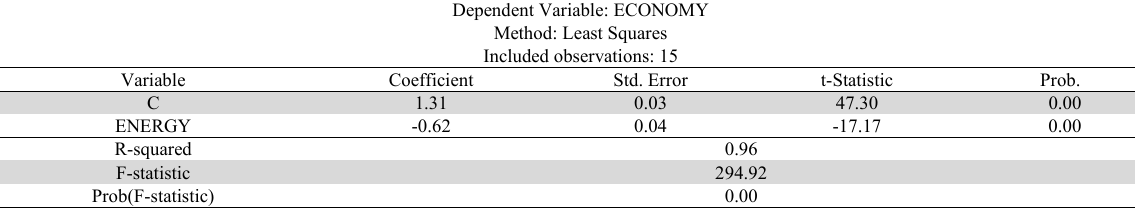
Regression analysis